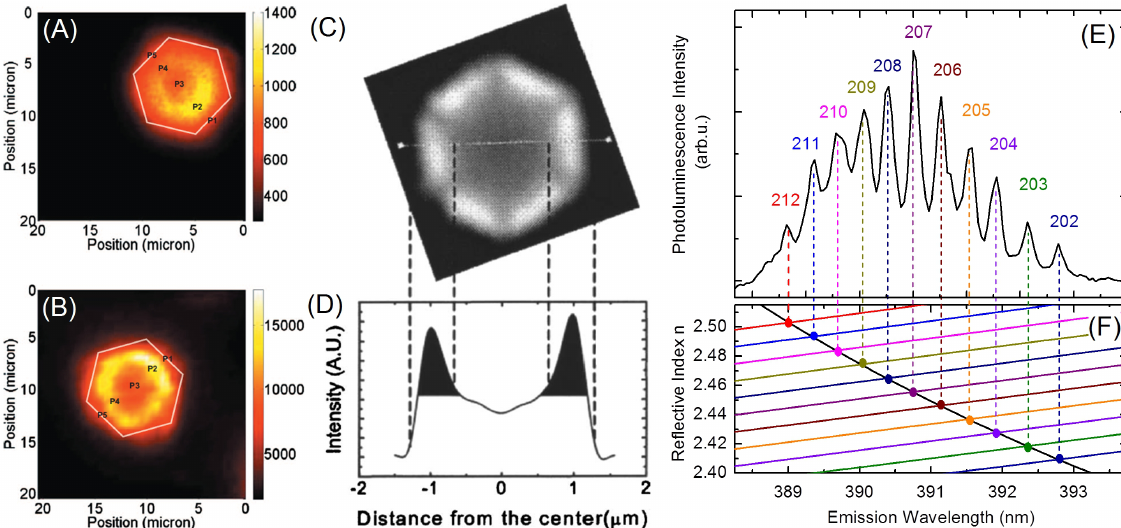
Figure 7: PL images of a ZnO microdisk (A) at room temperature and (B) at 10 K. The images are constructed from intensities at 383.6 and 370.1 nm, respectively. (C) Monochromatic CL image of a ZnO nanodisk at 378 nm. The side length of the ZnO hexagonal nanodisk is ap- proximately 1.5 µ m. (D) The intensity profile across the nanodisk. The darkened area indicates the luminescence contribution from the WGMs emission. (E) PL spectrum of a ZnO microdisk. (F) The inverse functions of WGMs with the corresponding mode numbers given in (E). The wavelengths are determined by the intersection points with the Sellmeier’s first order dispersion function. Reproduced with permission from Ref. [92] (A, B), [86] (C, D), and [68] (E, F). PL: photoluminescence; CL: cathodoluminescence; WGMs: whispering-gallery